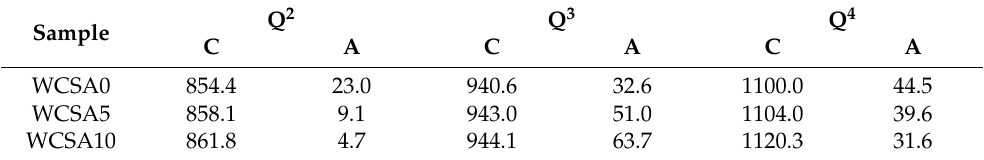
Table 3. Peak center (C) and relative area (A) from the curve fitting in the range of 773–1250cm − 1 .